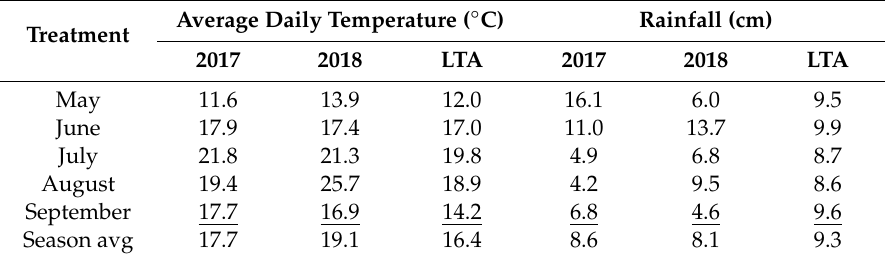
Table 2. Average daily temperature and total rainfall for the months of May through September at the St. Albans, ME research site for 2017 and 2018 compared with long-term (30-year) average (LTA)